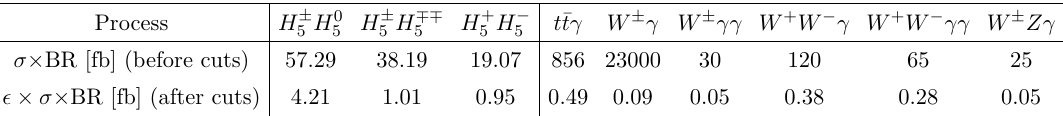
Table 3 . The cross section times branching ratio of each process before and after applying the cuts for m 5 = 150 GeV, de(cid:12)ned as for the (cid:12)ducial cross section in eq. (4.3). For the signal processes, we W (cid:6) (cid:13) ) = 100% and use BR( W (cid:6) ‘ (cid:6) (cid:23) ) assume BR( H (cid:6) 21 : 34%. 5 ! ! (cid:25) The cuts are optimized for the best signal signi(cid:12)cance for each value of m 5 . 6 For example, for m 5 = 150 GeV, we